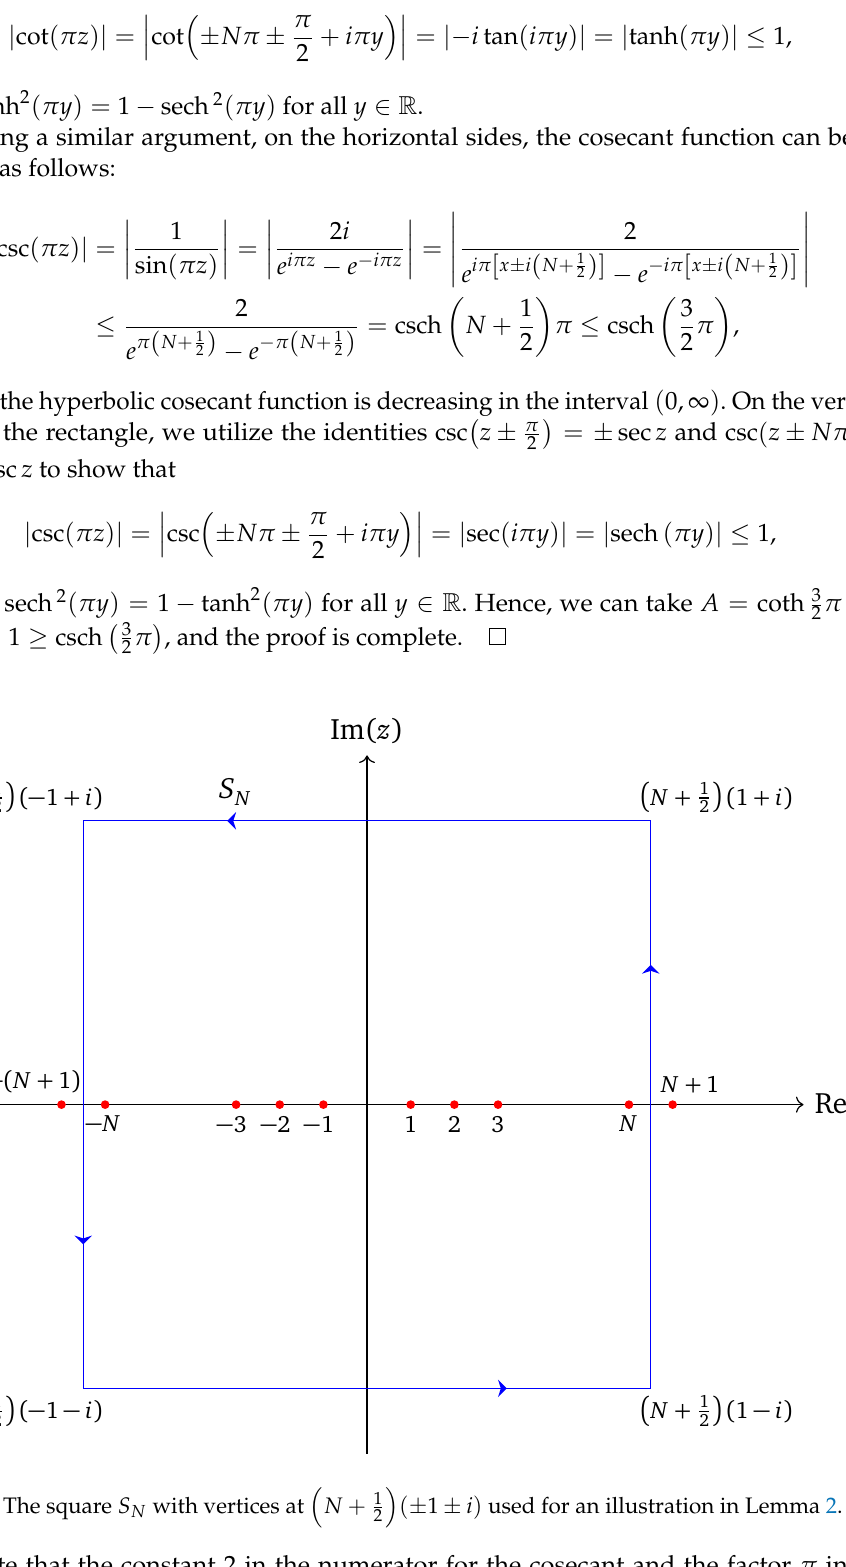
with vertices at N